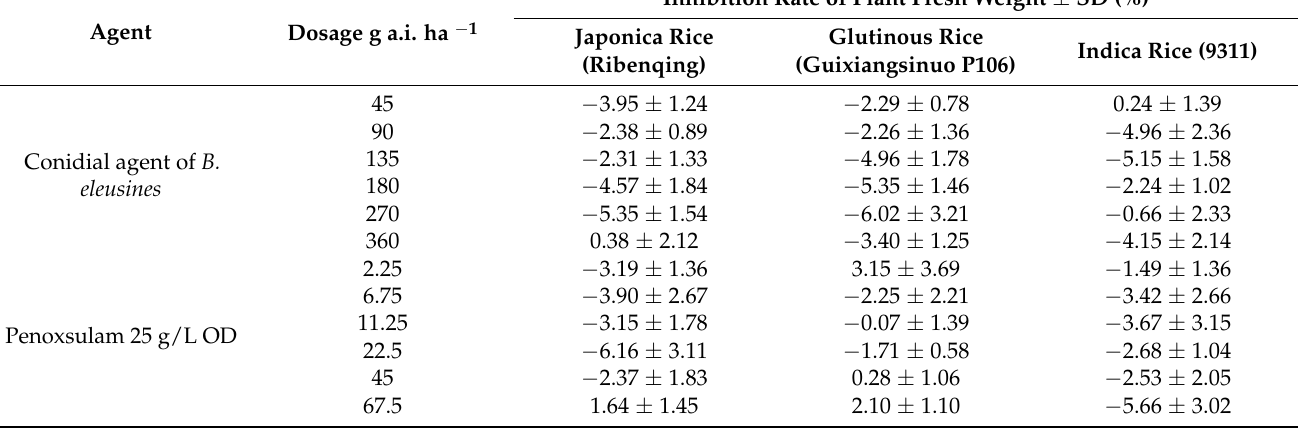
Table 2. Inhibition rate of fresh weight of B. eleusines conidial agent and 25 g/L penoxsulam OD on three rice